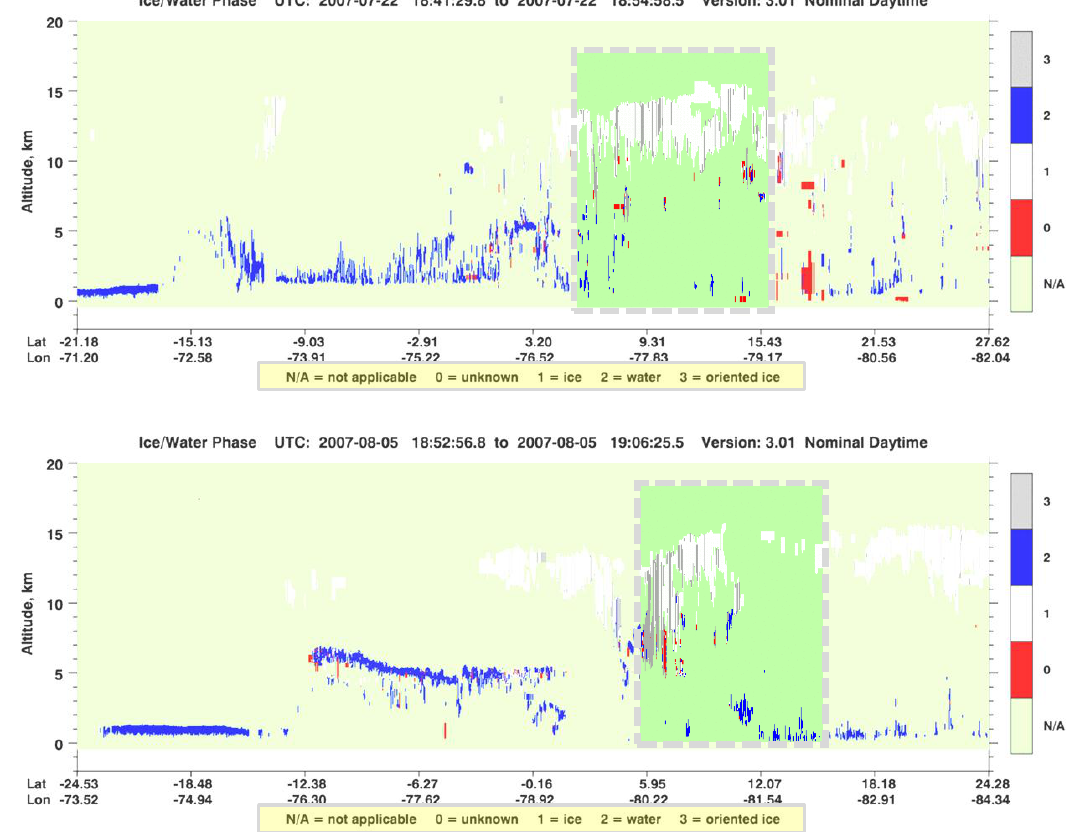
Fig. 13. CALIPSO/CALIOP discrimination of cloud phase for the two days studied here. The TC4 region considered in this study is bounded by the dashed box containing the green background. Blue and possibly red regions are dominated by liquid water. While coincident with MODIS sampling, the CALIPSO instrument samples only a narrow swath of the MODIS cloud scene due to the narrow field-of-view of the CALIOP